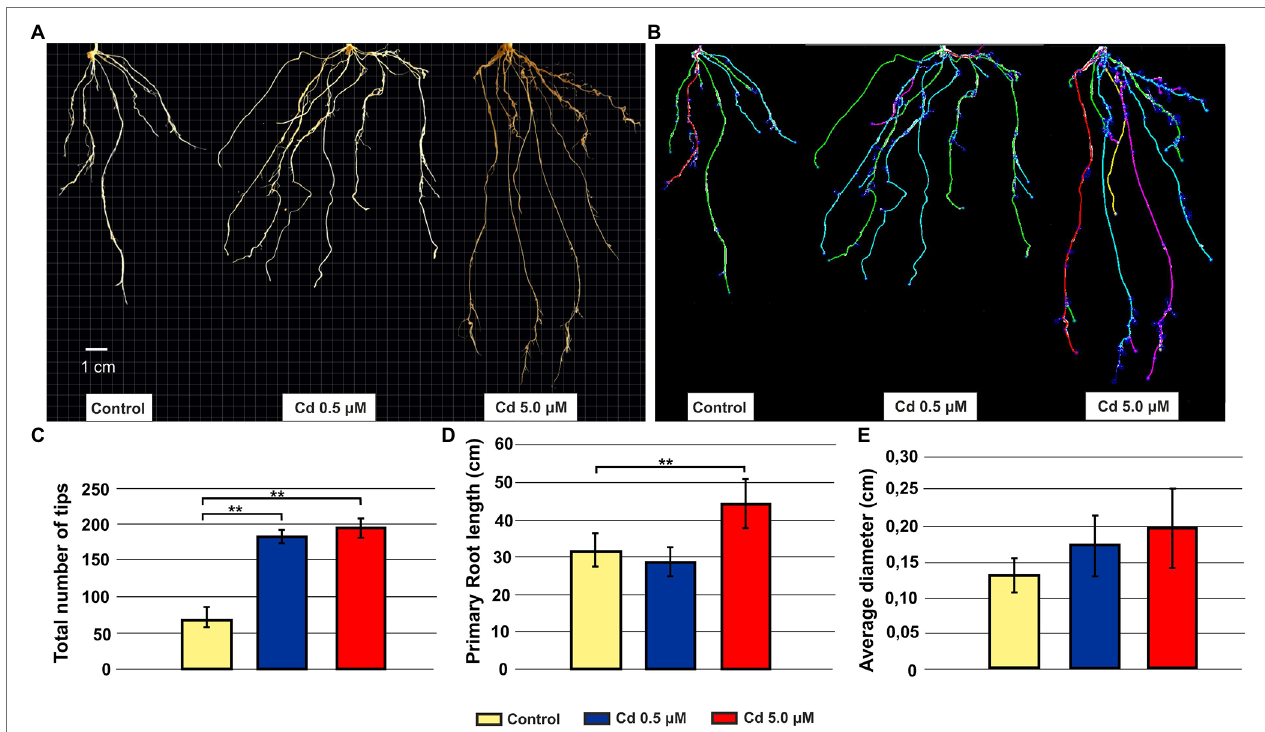
FIGURE 1 | Effect of exogenous Cd on the morphology of roots from seedlings grown in hydroponics for 15 days (starting from sprouting) in the presence of Cd 0.5 and 5.0 μ M. Panel (A) Representative pictures of roots grown in absence or presence of Cd; panel (B) the same root systems of panel A tracked by the image analysis tool Root System Analyzer; panel (C) tips total number; panel (D) primary root length; and panel (E) root average diameter. T -test p <